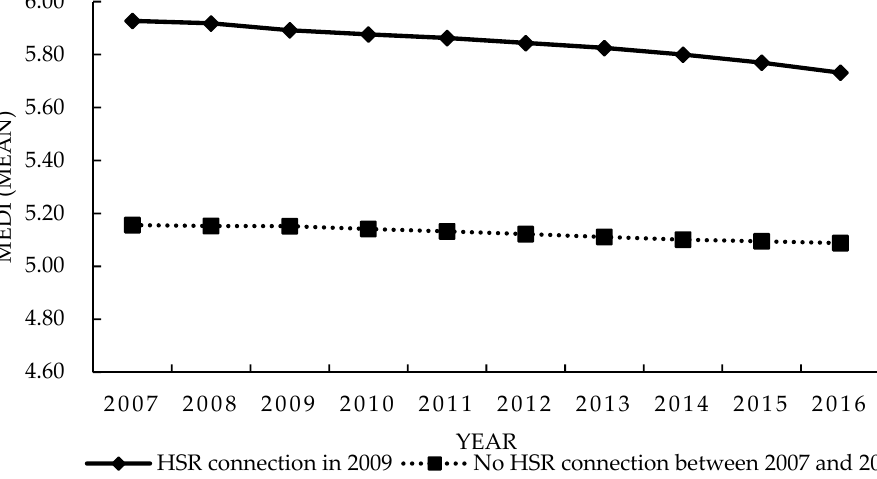
Figure 5. Parallel trend test of the HSR.